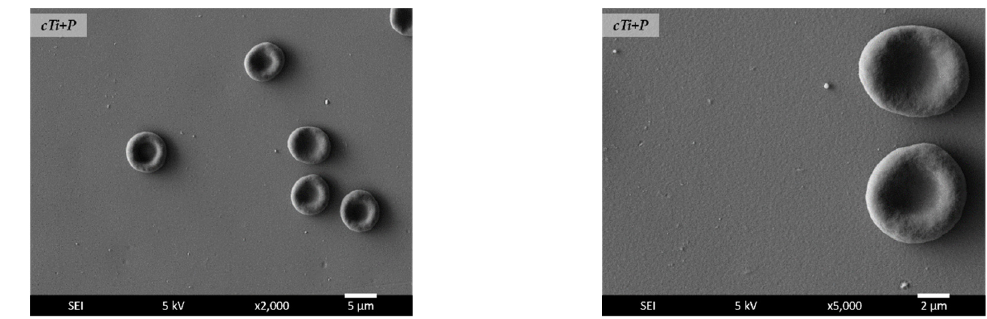
Figure 13. Platelets interacting with plain titanium ( pTi ), plain titanium plasma ‐ treated ( pTi+P ), nanopatterned Ti surface ( cTi ), and nanopatterned plasma ‐ treated surface ( cTi+P ) at different magnifications (left ‐ hand side 2 kX, right ‐ hand side 5 kX). Images were obtained from SEM analysis of samples incubated with whole blood.